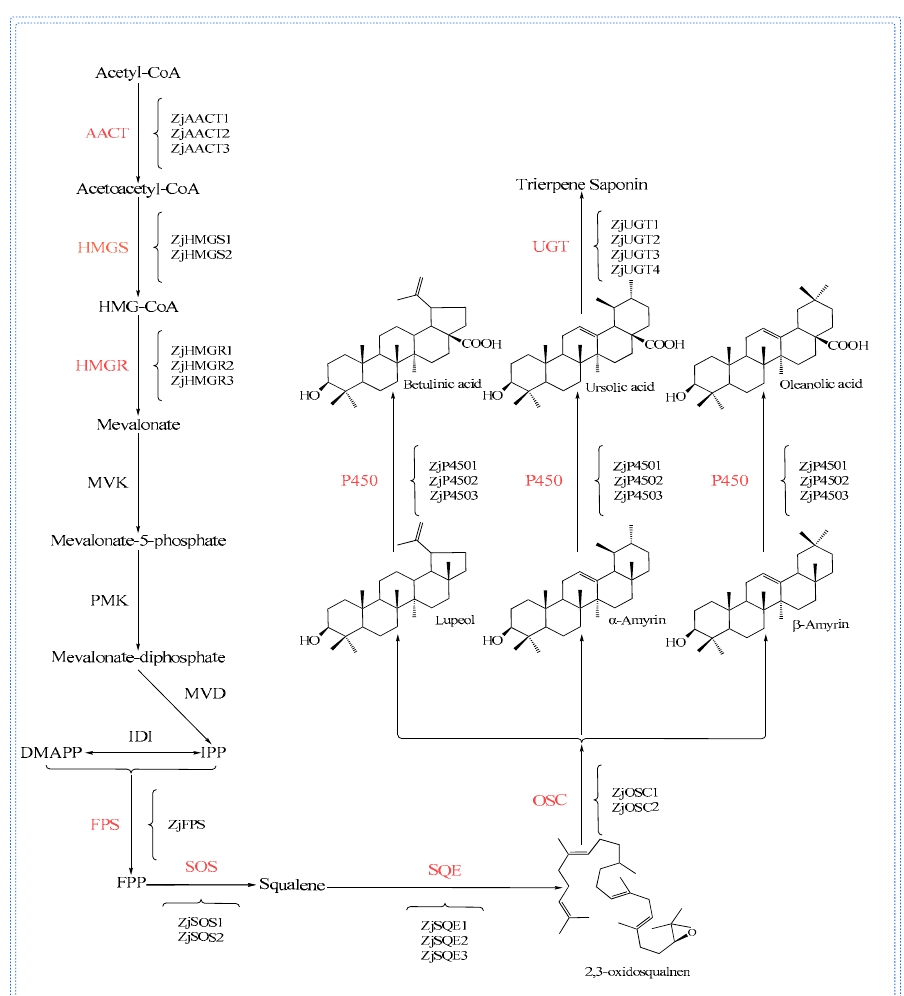
Figure 3. Major intermediates and key genes in the biosynthetic pathways of ZJ and ZA terpe-